Question: Summarize what this figure shows in one sentence.
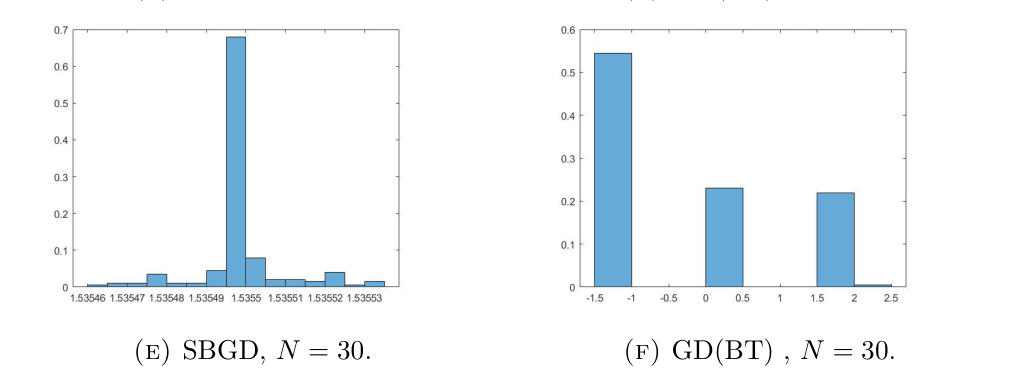
Answer: 1. Plot of the objective function (2.3).